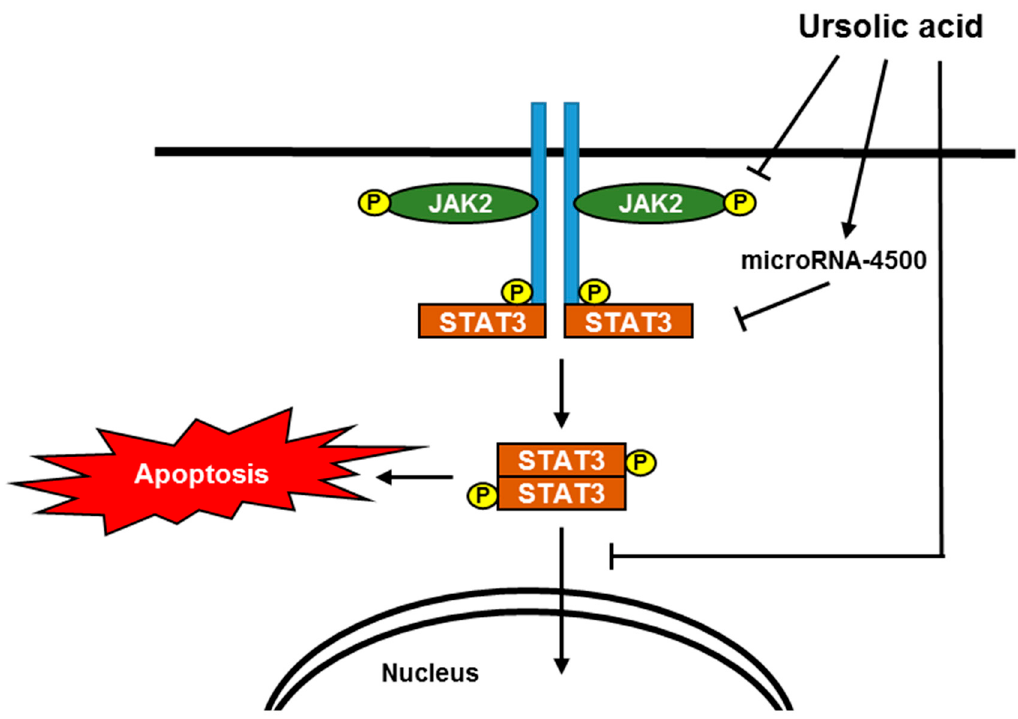
Figure 6. A schematic representation for the apoptotic mechanism of ursolic acid via upregulation of microRNA-4500 and inhibition of pJAK2/pSTAT3.